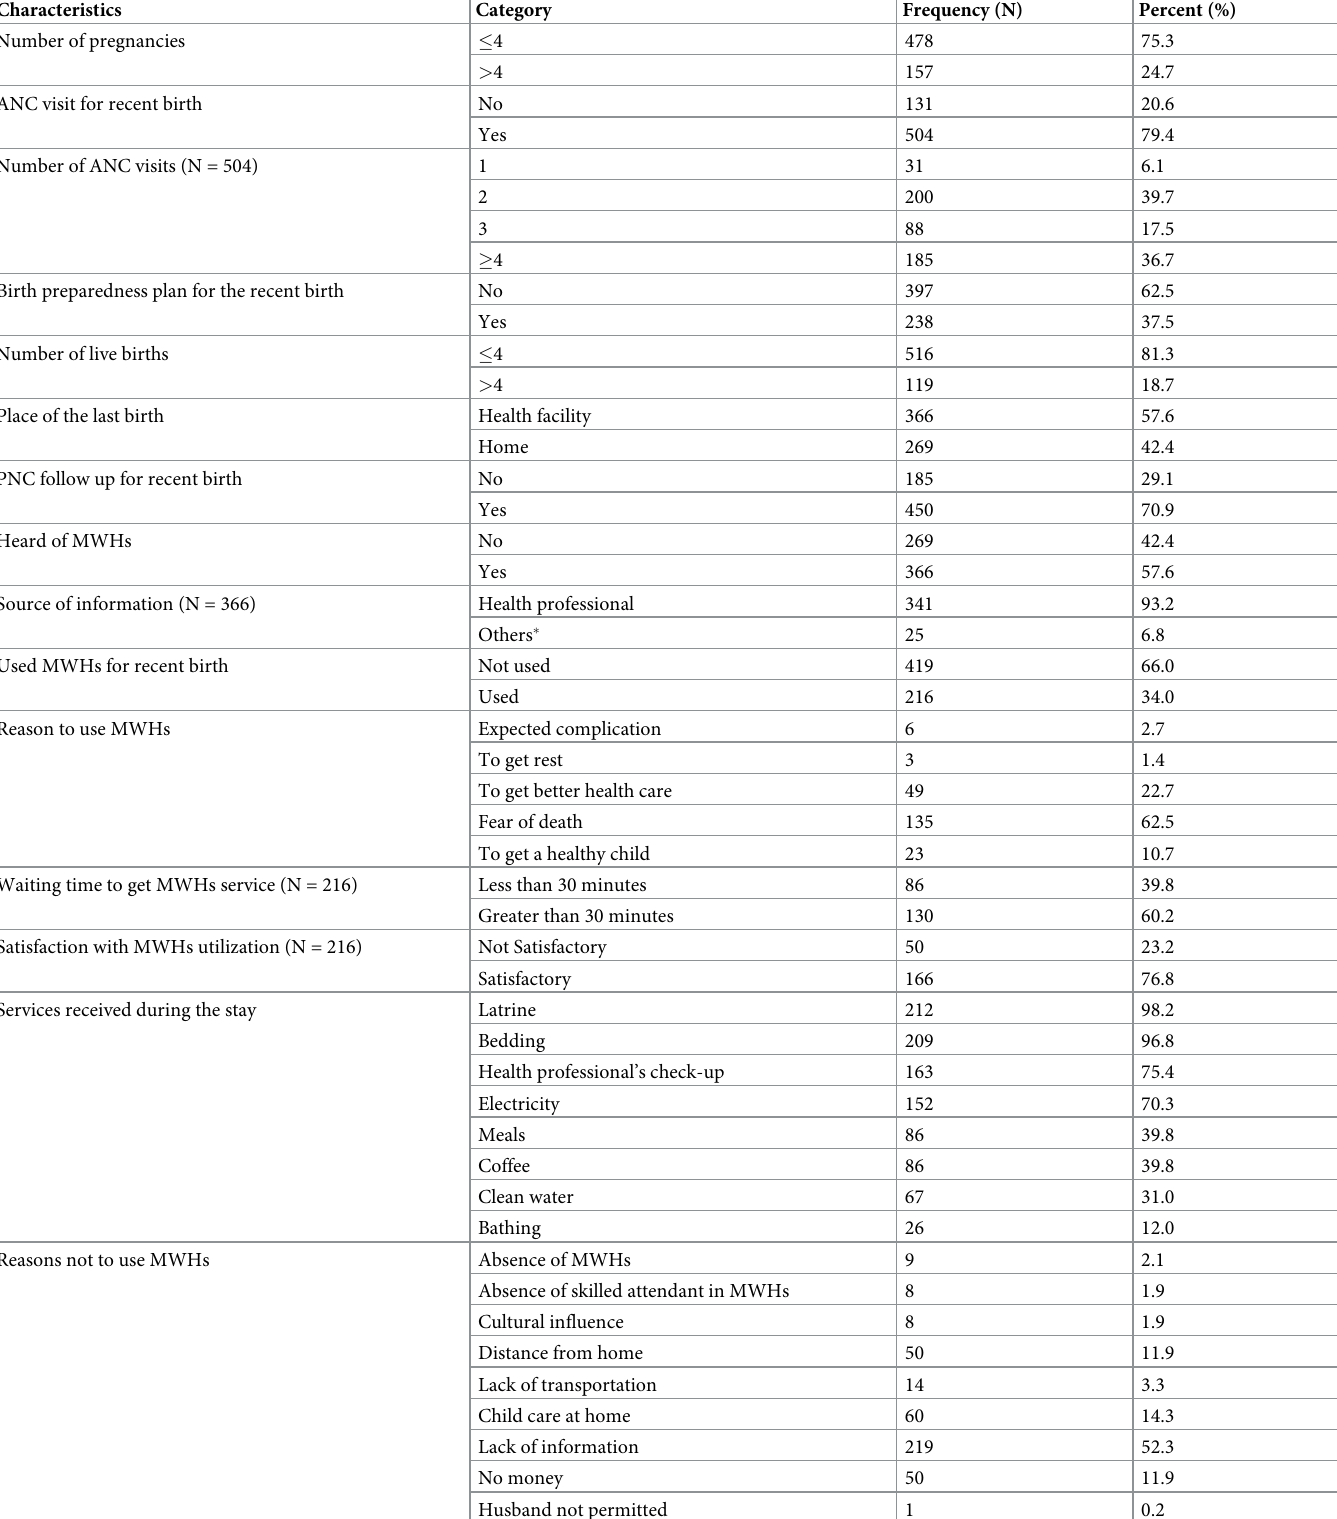
Table 2. Obstetric characteristics of childbearing women in Finfinnee special zone of central Ethiopia (N = 635).